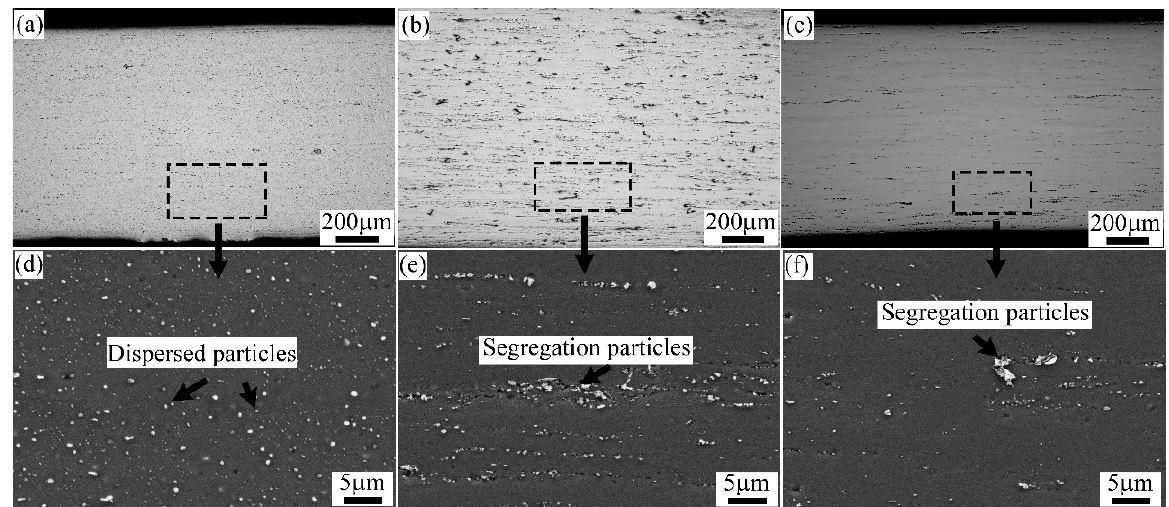
Figure 3. OM and SEM images of the second particles’ distribution in the cold-rolled alloy sheets: ( a , d ) A1 alloy, ( b , e ) A2 alloy, and ( c , f ) A3 alloy. ( a , d ) A1 alloy, ( b , e ) A2 alloy, and ( c , f ) A3